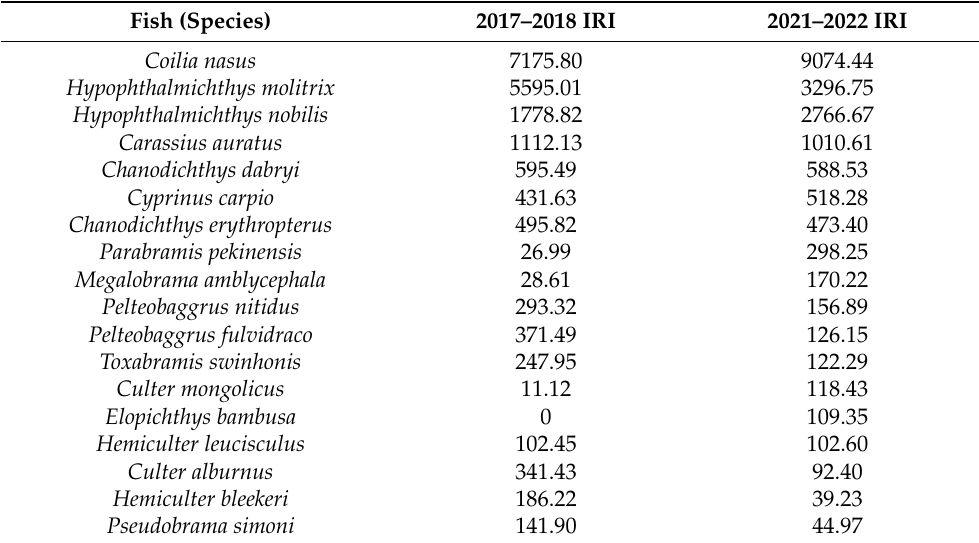
Table 2. Dominant species composition of fish in Gehu Lake before (2017–2018) and after (2021–2022) removal of the net